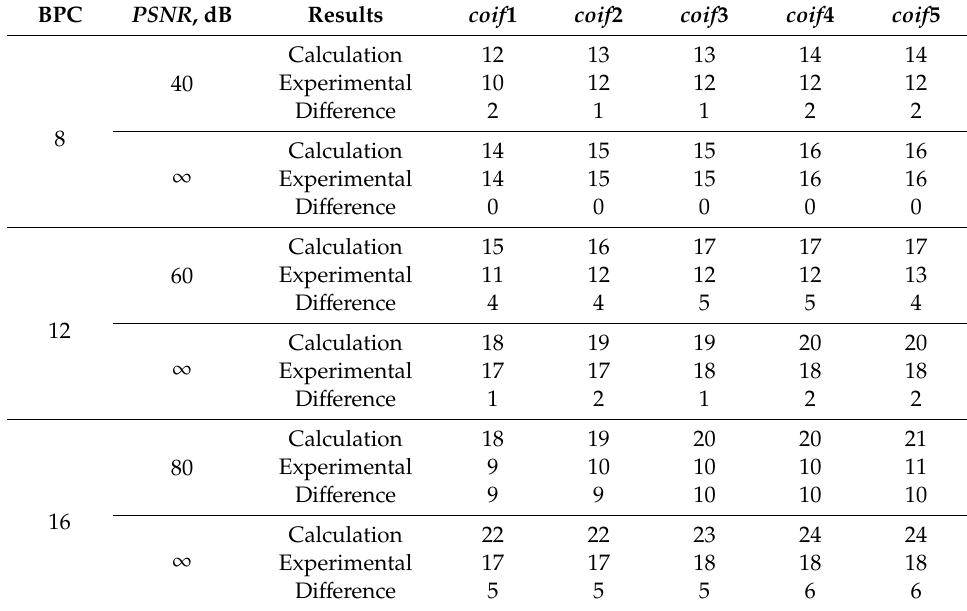
Table 33. Minimum values of r , at which the result of 3D tomographic images DWT by coiflets reaches high and maximum